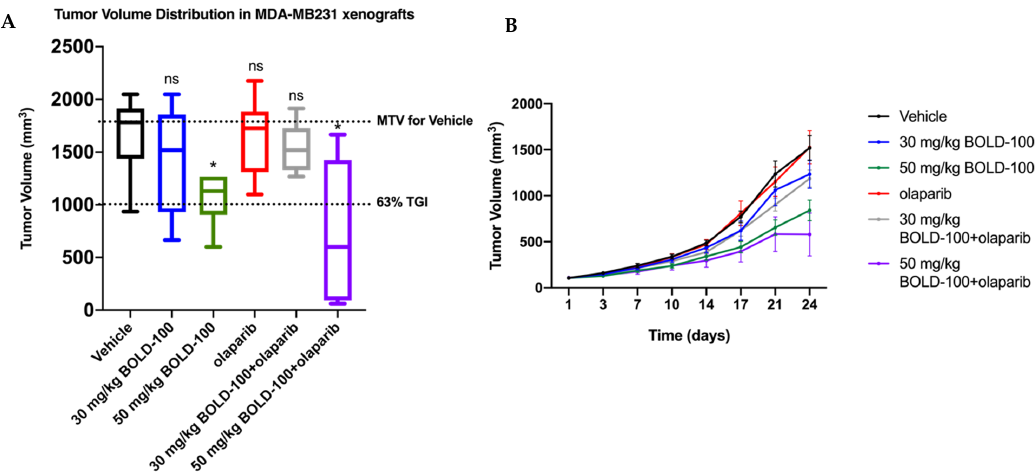
Figure 7. Combination of BOLD-100 and olaparib suppressed growth of TNBC xenografts. ( A ) Box and whisker plot showing distribution of tumor volume in each group of nude mice with MDA-MB-231 xenografts on Day 24 after treatment. Tumors treated with the combination of 50 mg/kg BOLD-100 and olaparib showed a 63% tumor growth inhibition (TGI), (TGI > 60% suggest a potential therapeutic activity), that differed significantly (* p ≤ 0.05, Mann–Whitney test) from vehicle or olaparib monotherapy but was not significantly different from BOLD-100 50 mg/kg. ns, not significant. ( B ) The mean tumor volumes in each treatment group were plotted as a function of time (days). For both graphs, colors are: vehicle (black), 30 mg/kg BOLD-100 (blue), 50 mg/kg BOLD-100 (green), olaparib (red), 30 mg/kg BOLD-100+olaparib (grey) and 50 mg/kg BOLD-100+olaparib (purple).